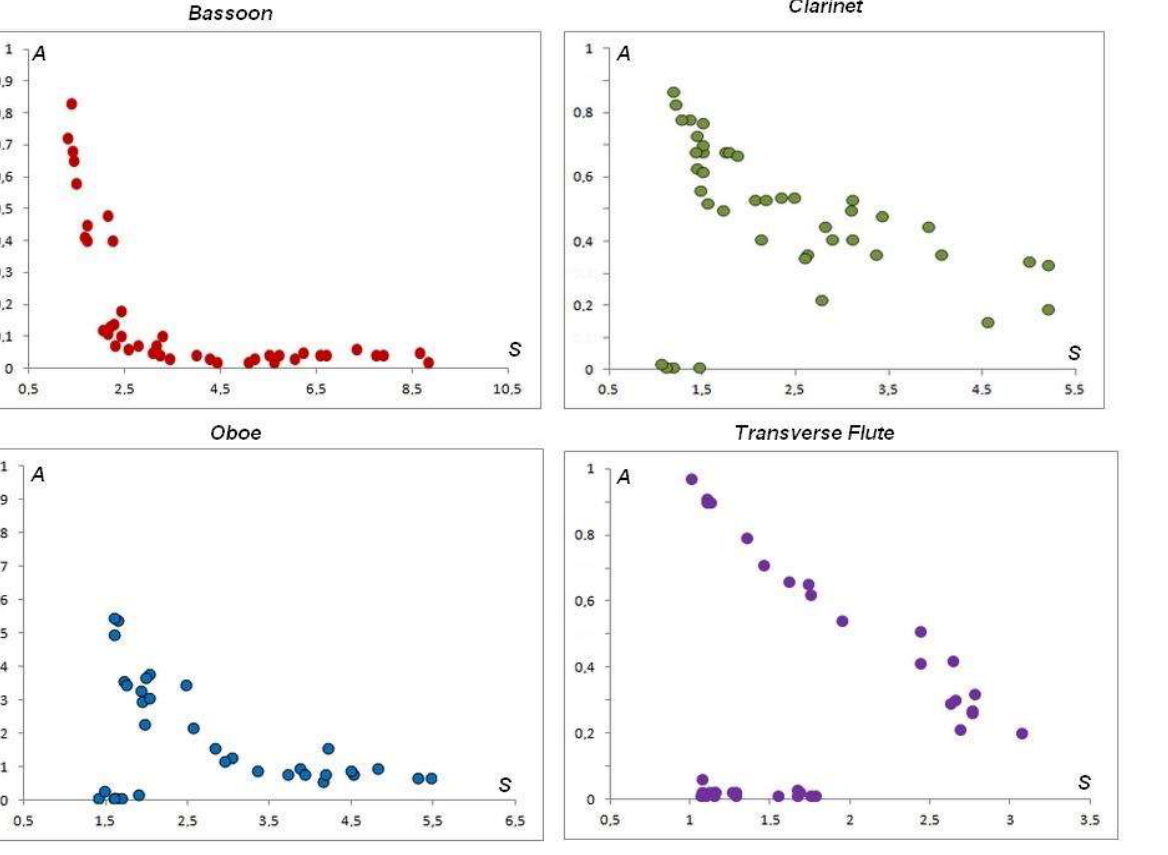
Figure 16. Two-dimensional representation in the A – S plane of the timbral space of the coefficients for the selected aerophones.